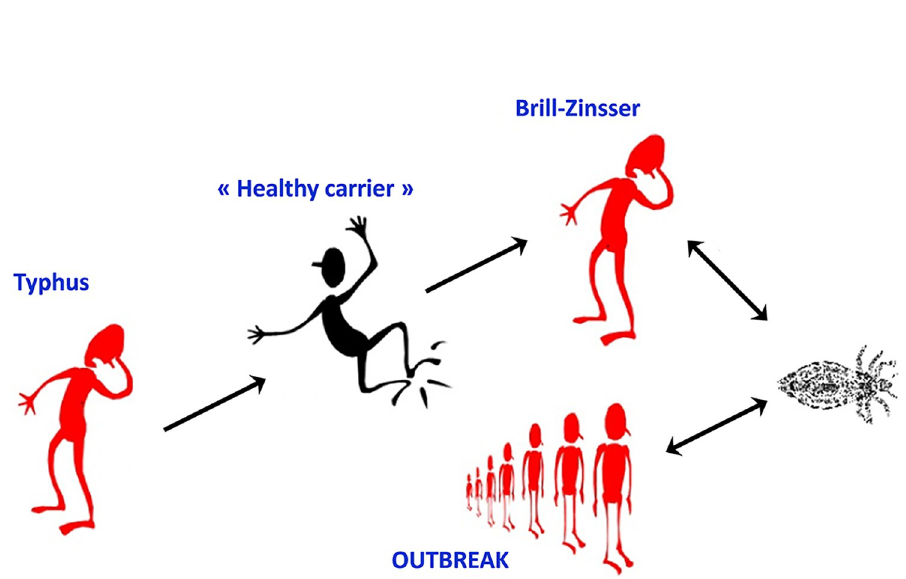
Fig 3. Body lice as the cause of typhus reemergence. R . prowazekii is classified as a category B bioterrorism agent. It is stable in dried louse feces and can be transmitted through aerosols. Detection of the pathogen in body lice is crucial for monitoring the transmission risk to humans. However, Brill–Zinsser disease, a relapsing form of epidemic typhus that may develop as sporadic cases up to 40 years after the initial acute infection, is unrelated to louse infestation but to stress or a waning immune system that initiates the reactivation of an earlier and latent infection. Patients developing Brill–Zinsser disease may, in turn, be the source of new outbreaks when conditions facilitate louse infestation and transmission [155]. The mechanism of R . prowazekii latency has not been established. Brill–Zinsser disease should be considered as a possible diagnosis for acute fever in any patient who has lived in an area where epidemic typhus was endemic [156].